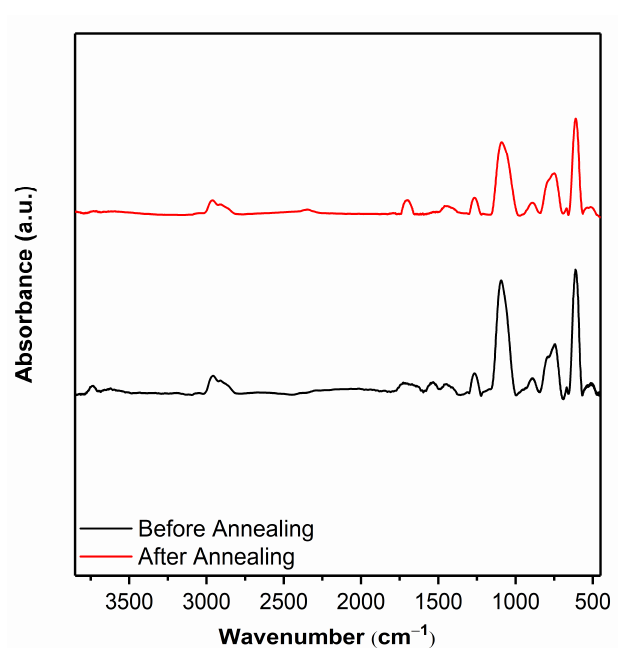
Figure 14. FTIR spectra of VCOP-1 films on c-Si substrate before and after annealing at 250 °C.